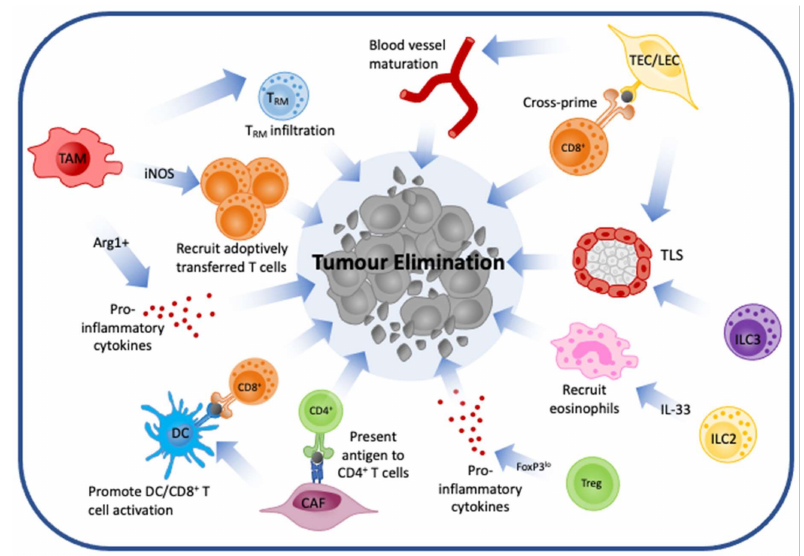
Figure 2. The anti-tumoral roles of classically pro-tumoral cells in the tumour microenvironment. TAMs, TECs, CAFs, ILCs and T regs are often classified as pro-tumoral, however growing evidence supports anti-tumoral roles for these cells which aid in the elimination of cancer. These include the secretion of pro-inflammatory cytokines and the activation of additional anti-tumoral cells, in particular effector CD8 + T cells. TAM: tumour associated macrophage, TEC/LEC: tumour endothelial cell/lymphoid endothelial cell, CAF: cancer associated fibroblast, T RM : tissue resident memory T cell, DC: dendritic cell, ILC: innate lymphoid cell, TLS: tertiary lymphoid